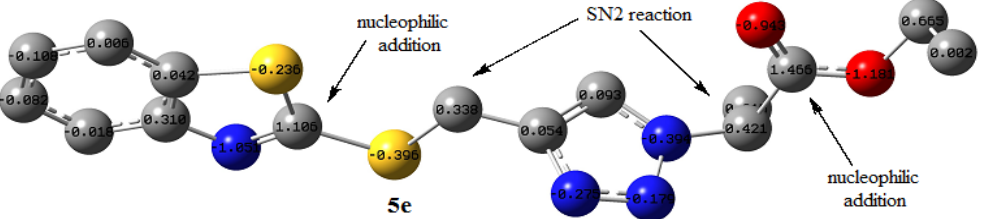
Figure 5. Possible nucleophilic sites in 5e , based on NBO analysis and the electrophilicity index (hydrogen atoms are omitted for clarity).